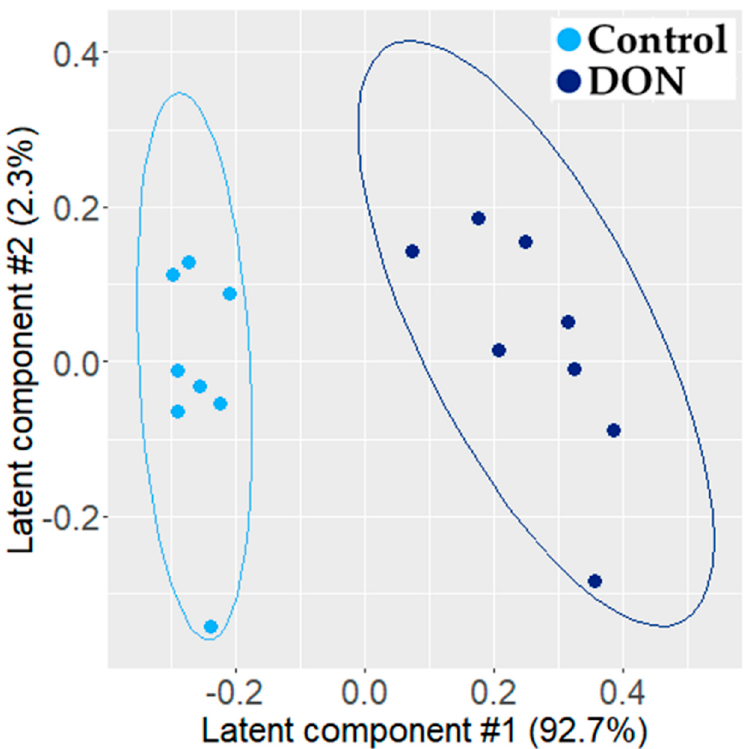
Figure 1. Two-dimensional PLS-DA (R2 = 95% and Q2 = 0.91) score plot of the integrated 1H NMR spectra of jejunum explant extracts (control, n = 8, light blue dot; DON-exposed, n = 8, dark blue dot). Each dot corresponds to an individual.